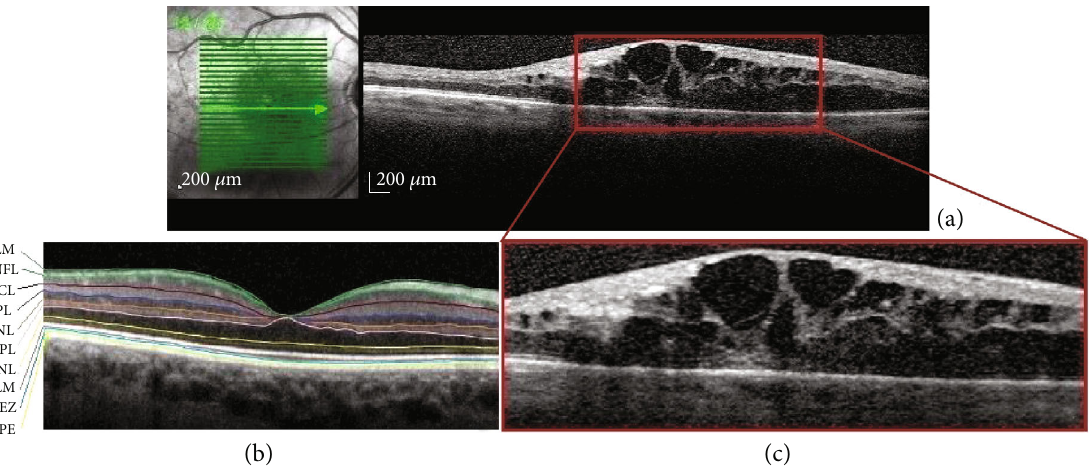
Figure 4: OCT aspect of macular DRIL. (a) Disorganization of the inner retinal layers (DRIL). (b) Normal macular segmentation. (c) Magni fi ed segment of the fi rst image (a); global disruption of the ellipsoid zone and RNFL. ILM: internal limiting membrane; RNFL: retinal nerve fi ber; GCL: ganglion cell layer; IPL: inner plexiform layer; INL: inner nuclear layer; OPL: outer plexiform layer; ONL: outer nuclear layer; ELM: external limiting membrane; PR/EZ: photoreceptor layer/ellipsoid zone (inner and outer photoreceptor segment junction); RPE: retinal pigment